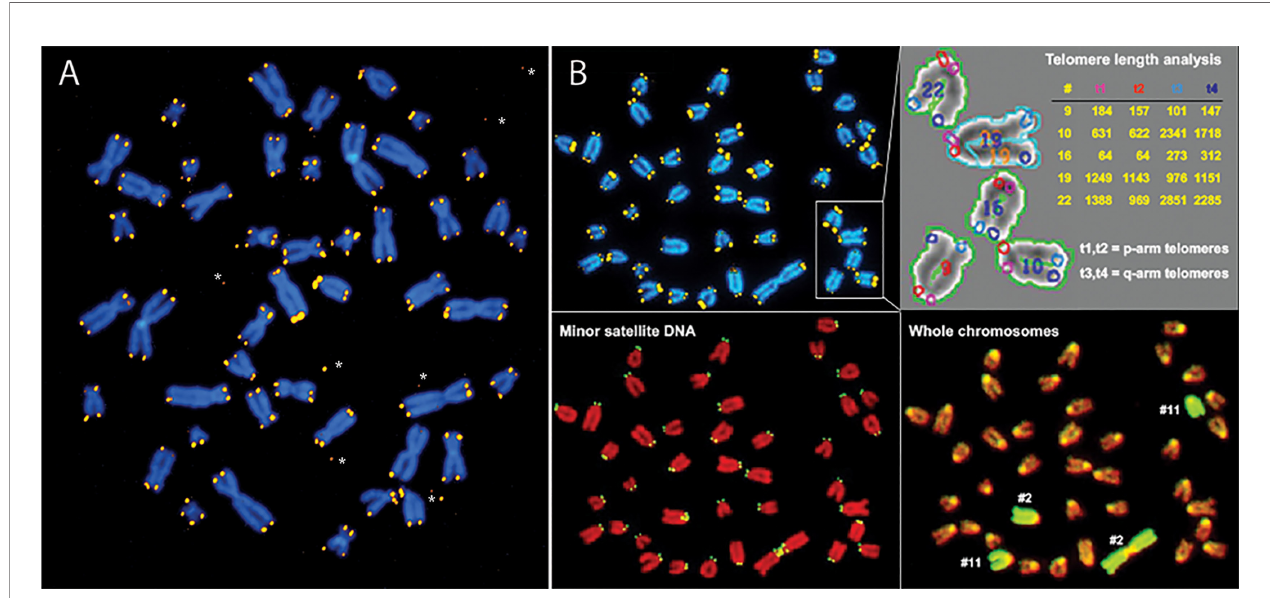
FIGURE 1 | Q-FISH shows extreme variability in the length of telomere repeats in human (A) and mouse (B) chromosomes. (A) Human metaphase chromosomes stained with DAPI (blue) from a cultured fi broblast following hybridization with Cy3 labeled (CCCTAA) 3 PNA (yellow). Note the large variation in telomere fl uorescence intensity at individual chromosome ends, discrepancies in telomere fl uorescence between sister chromatids and occasional telomere fl uorescence spots outside chromosomes*. (B) Mouse metaphase chromosomes from a cultured skin fi broblast hybridized sequentially with a mixture of different fl uorescent probes: fi rst Cy3 labeled (CCCTAA) 3 PNA ( B , top left panel) and FITC labeled CGGCATTGTAGAACAGTG PNA speci fi c for mouse minor satellite sequences ( B , bottom left panel) followed by staining of DNA with DAPI, image acquisition and hybridization with FITC labeled chromosome paint probe speci fi c for respectively chr2 and chr11 ( B , bottom right panel). Telomere length was analyzed using the TFL-Telo software ( B , top right panel) (28). Note the very short telomeres on the short arm of chr “ 16 ” and the very long telomeres on the long arm of chr “ 22 ” (arbitrary chromosome numbers and fl uorescence intensity values). For details see (29,